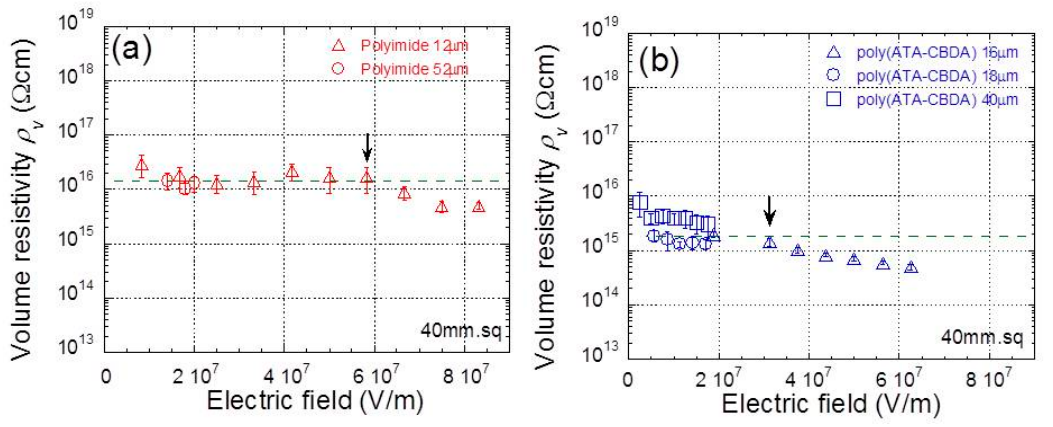
Figure 6. Relationship between electric resistivity and electric field strength for ( a ) polyimide and ( b ) biopolyimide films with different thicknesses.